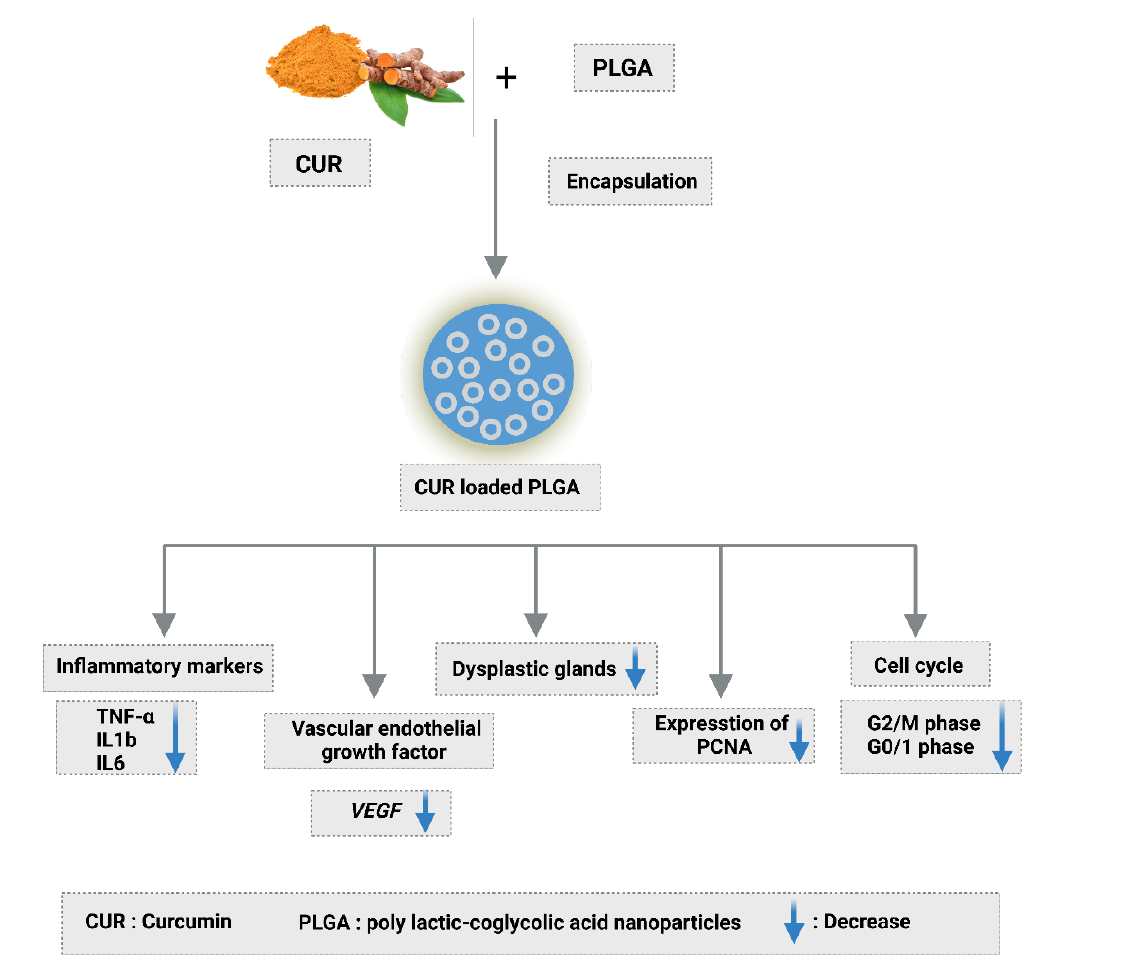
Figure 11. Nanocurcumin loaded PLGA effects.